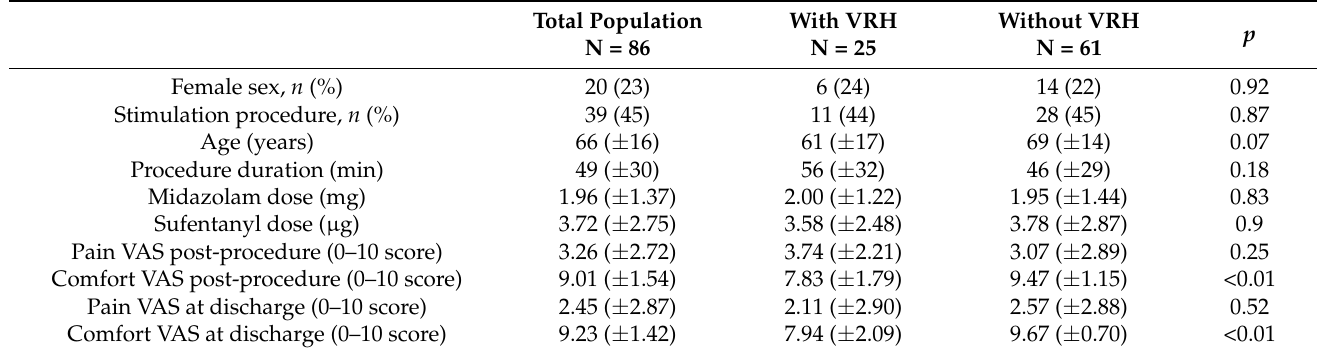
Table 3. Baseline characteristics of the population and the group comparison. VRH: virtual reality hypnosis; VAS: visual analogue scale. The VAS consisted of 10 score gradations (1 for the most pain or the worst comfort and 10 for the least pain and the best comfort) with an additional 10 sub-gradations for each point.